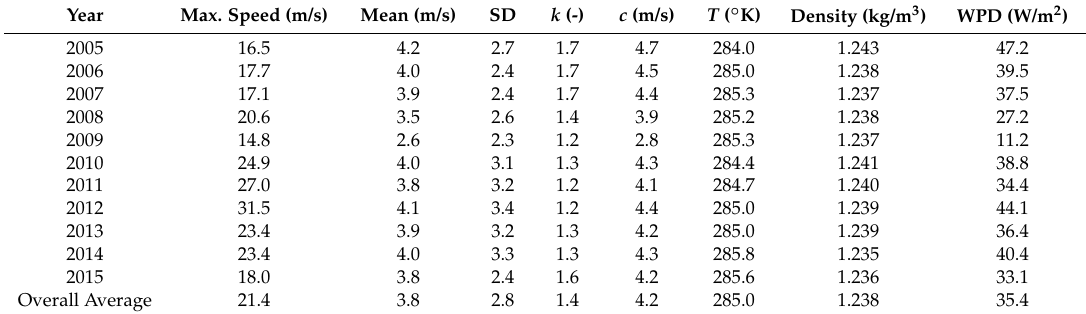
Table 2. Long term wind data analysis of Deokjeok-do at 10 m from local ground.